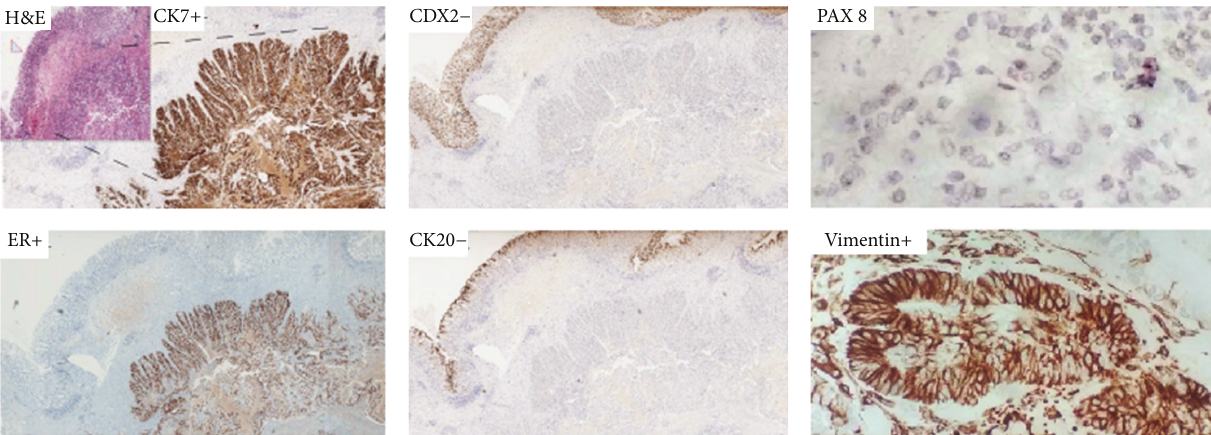
Figure 4: Immunohistochemistry. Hematoxylin and eosin stain (H&E stain) with unharmed mucosa (arrow), CK7+, ER+, CDX2 − , CK20 − , antivimentin Ab+, and PAX 8+